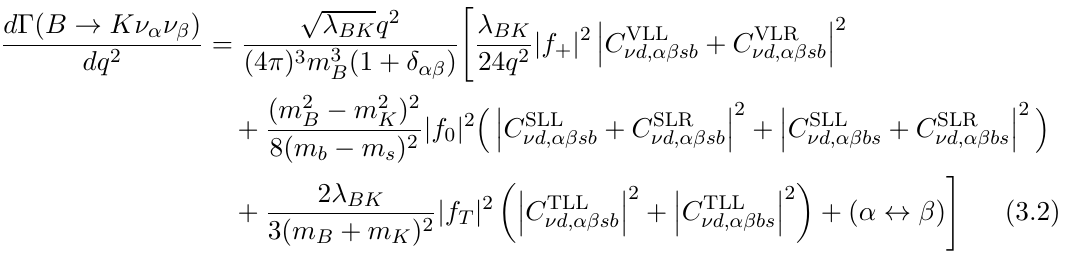
where q 2 denotes the square of the 4-momentum of the neutrino pair and ¯ G (0) ( q 2 ) is